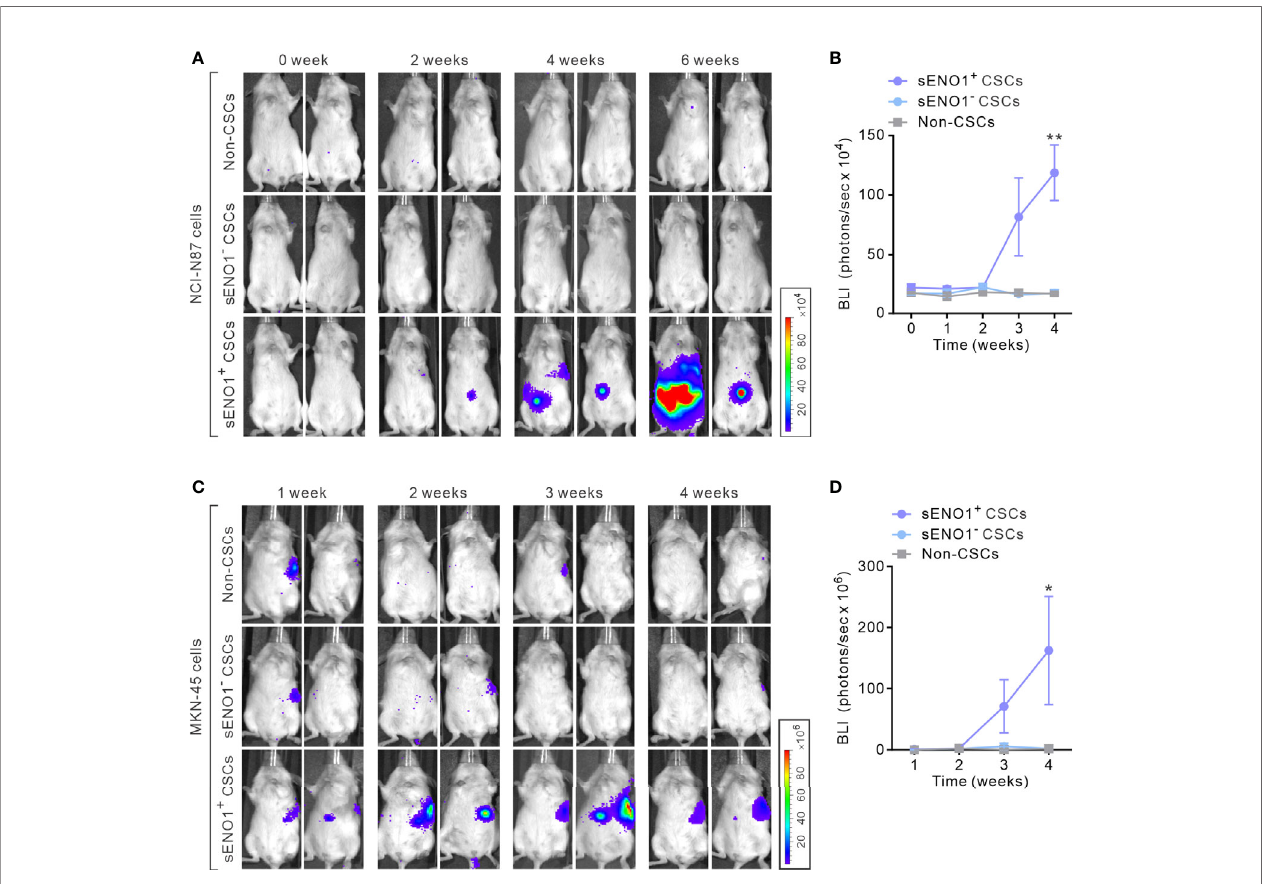
FIGURE 3 | sENO1 + CSCs are highly pro-metastatic. (A) Representative BLI of NOD/SCID mice receiving an intra-splenic injection of sENO1 + CSCs (represented by CD90 + NCI-N87 cells), sENO1 - CSCs (CD90 - NCI-N87 cells), and non-CSCs (represented by CD90 - cells). at the indicated time following cell inoculation. (B) Tumor bulk quanti fi ed as BLI normalized photon counts as a function of time. Error bars represent mean ± SEM from one experiment (n = 8 mice per group). Unpaired t-test was performed throughout where **p < 0.01 versus non-CSCs. (C) Representative BLI of NOD/SCID mice receiving intra-splenic injection of sENO1 + CSCs (represented by CD90 + MKN-45 cells), sENO1 - CSCs (CD90 - MKN-45 cells) and non-CSCs (represented by CD90 - cells). at the indicated time following cell inoculation. (D) Tumor bulk quanti fi ed as BLI normalized photon counts as a function of time. Error bars represent mean ± SEM from one experiment (n = 8 mice per group). Unpaired t-test was performed throughout where *p < 0.05 versus